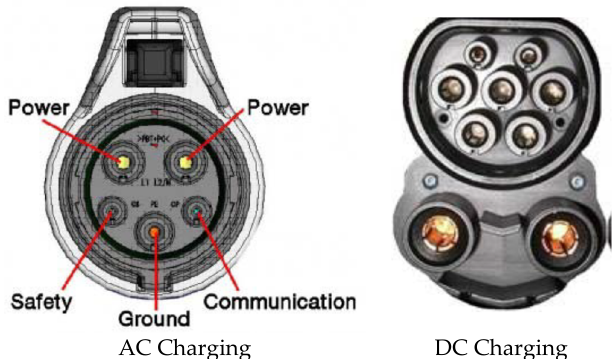
Figure 20. AC and DC charging socket structure. These sockets are attached with the vehicle and